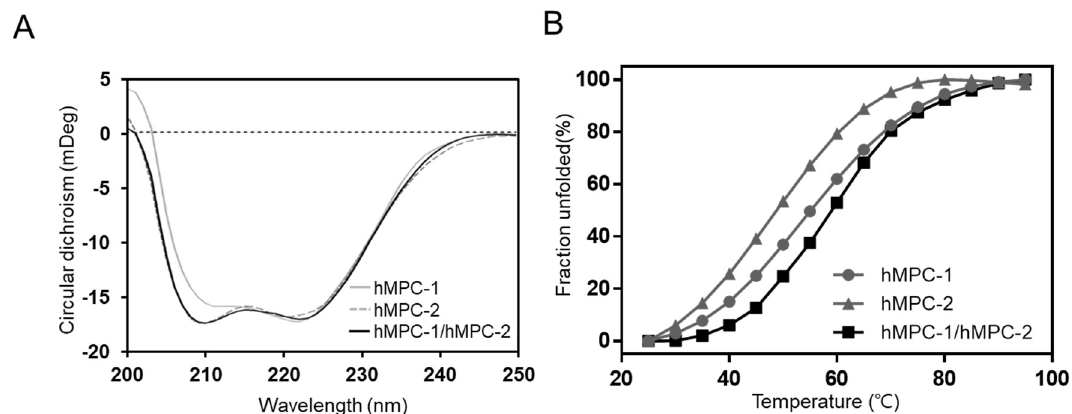
Figure 5. Secondary structure and thermal stability of hMPC-1, hMPC-2, and hMPC-1 / hMPC-2. ( A ) Far-UV circular dichroism spectra (200–250 nm) of hMPC-1 (light gray line), hMPC-2 (dark gray dashed line), and hMPC-1 / hMPC-2 (black line). ( B ) The melting temperature ( T m ) was calculated by the decrease in intensity values at 217 nm in the CD spectrum. T m values for hMPC-1 (light gray line with circle), hMPC-2 (dark gray line with triangle), and hMPC-1 / hMPC-2 (black line with square) were 54.4 ± 0.86 ◦ C, 47.6 ± 1.23 ◦ C, and 58.5 ± 1.33 ◦ C, respectively. All experiments were repeated three times to calculate the standard deviation.